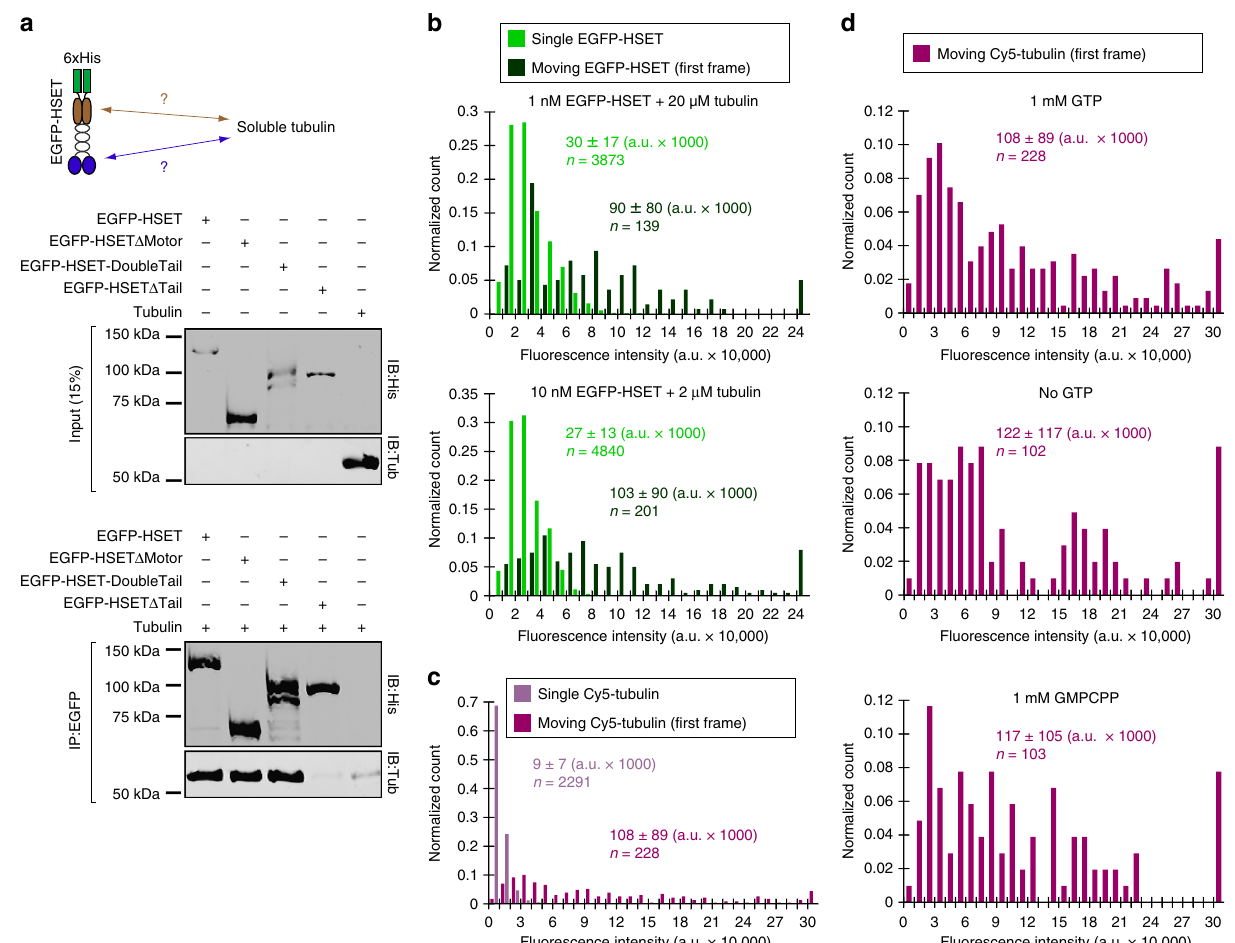
Fig. 3 Soluble (non-MT) tubulin binding to N-terminal HSET tail domain induces HSET-tubulin clustering to activate long-range unidirectional motion. a Co- immunopreciptation of puri fi ed HSET with soluble tubulin. The indicated EGFP-HSET truncation (50 nM concentration) was incubated with soluble tubulin (250 nM concentration) and the common EGFP-tag was used for immunoprecipitation. Inputs were loaded at 15% of total protein. A representative blot from N = 2 independent experiments is shown. b Fluorescence intensity analysis of EGFP-HSET diluted to single-molecule levels and adhered to a glass cover slip (light green) compared to the fi rst frame of moving EGFP-HSET after the addition of tubulin (dark green, concentrations indicated). The fl uorescence intensity of individual EGFP-HSET particles was determined by Gaussian fi t, and intensity distributions were plotted as histograms for the population, where normalized count is the observed value in the bin divided by the total number of particles. Data are reported as the arithmetic mean ± SD for the indicated n particles from 2 independent experiments, where N ≥ 4 movies for each condition. c , d Fluorescence intensity analysis of Cy5-tubulin diluted to single-molecule levels and adhered to a glass cover slip (light purple) compared to the fi rst frame of moving Cy5-tubulin (10 nM) in the presence of 10 nM unlabeled HSET (dark purple). The fl uorescence intensity of individual Cy5-tubulin particles was determined by Gaussian fi t, and intensity distributions were plotted as histograms for the population. Data are reported as the arithmetic mean ± SD for the indicated n particles from 2 independent experiments where N = 6 movies for moving Cy5-tubulin. For d , fl uorescence intensities were determined in the presence of the indicated guanine nucleotide, where N ≥ 2 movies for each condition. All experiments were performed in BRB80 + 50 mM KCl with 0.5 mg/mL